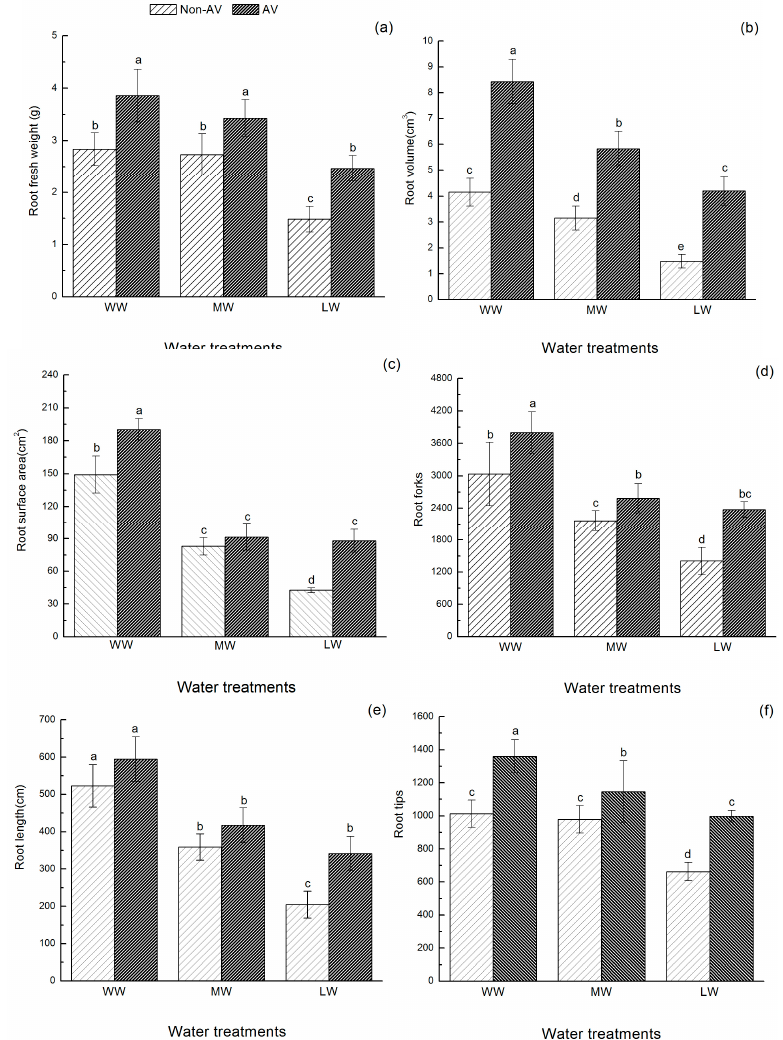
Figure 3. Effects of A. vagum on fresh root weight ( a ), root volume ( b ), root surface area ( c ), root forks ( d ), root length ( e ), and root tip number ( f ) of O. hosiei seedlings under drought stress conditions. Treatments: Non-AV, non- A. vagum ; AV, A. vagum; WW, well watered; MW, moderate water; LW, low water. Thick bars represent the means and thin bars represent standard errors for n = 5. Different letters indicate group with significant differences for p < 0.05.